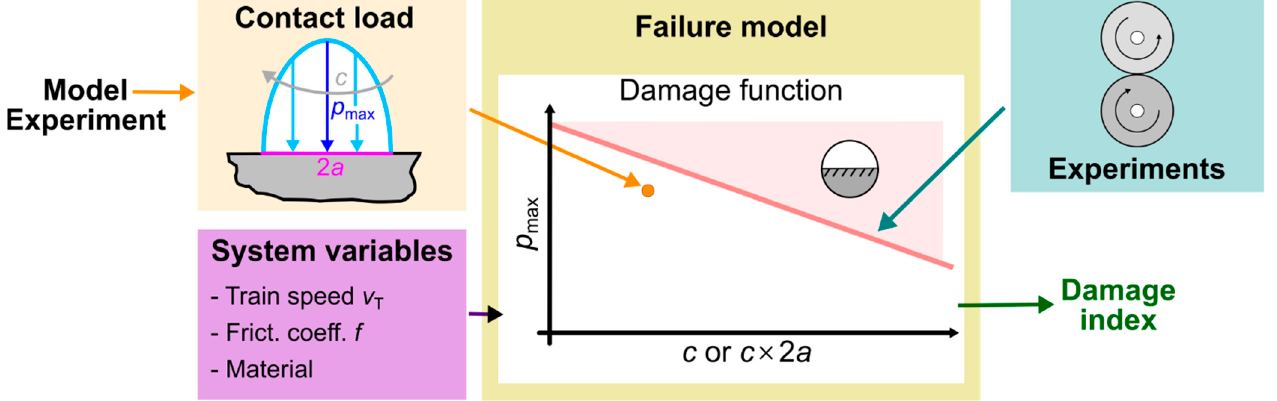
Figure 4. Standardized calculation scheme to implement failure models and efficiently compute damage indices at the local contact-patch level.